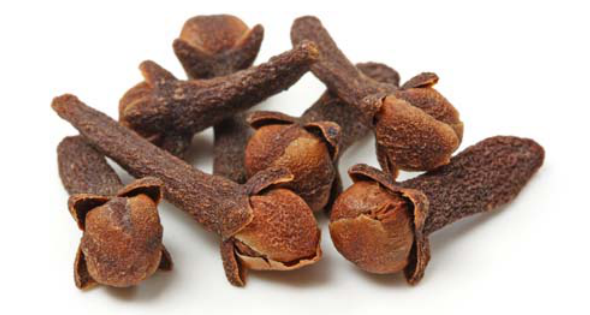
Figure 1. The dried flowerbuds of Eugenia caryophyllata , known as